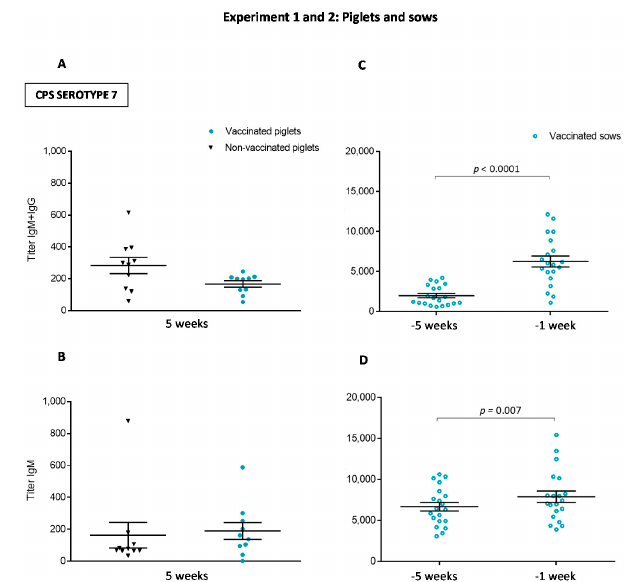
Figure 11. Experiment 1 and 2: Total Ig and IgM profile of antibodies against S. suis serotype 7 purified capsular polysaccharide (CPS) from either vaccinated or non-vaccinated piglets from Experiment 1 ( A , B ) and vaccinated sows from Experiment 2 ( C , D ). Randomly selected 20 piglets (10 vaccinated and 10 non-vaccinated) from Experiment 1 and 20 randomly selected vaccinated sows from Experiment 2 were used for the quantification of antibodies against S. suis serotype 7 CPS. Total Ig [IgG + IgM] titers ( A , C ) and IgM titers ( B , D ) were determined by ELISA against purified S. suis serotype 7 CPS. Piglets were sampled at five weeks to evaluate titers of antibodies against serotype 7 CPS and sows were sampled at one and five weeks before parturition. Antibody titers for individual piglets or sows are shown with horizontal bars representing mean ± SEM. Values significantly different are shown in the graph with corresponding p value.